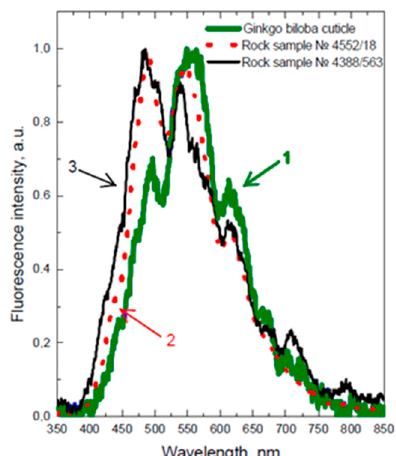
Figure 2. Laser-induced fluorescence spectra of (1) Ginkgo biloba cuticle, (2) rock sample No 4552/18, and (3) rock sample No 4388/563.